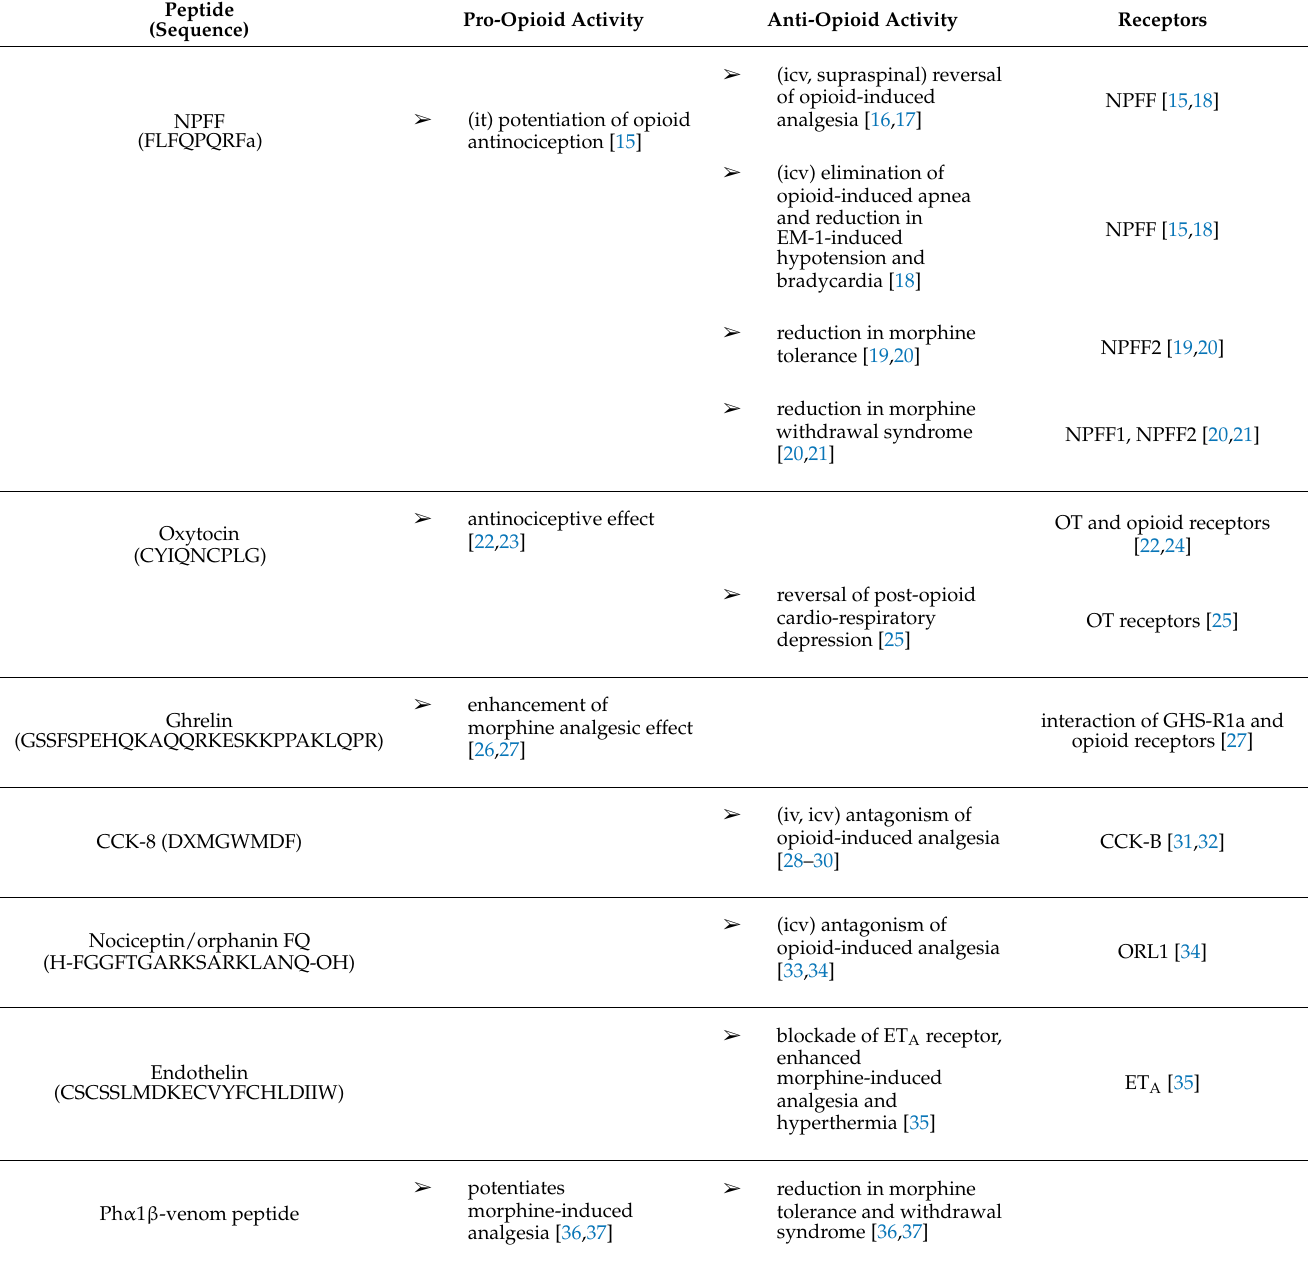
Table 1. Summary of the main pro- and anti-opioid effects of the described peptides. For more detailed information see the text. Peptide